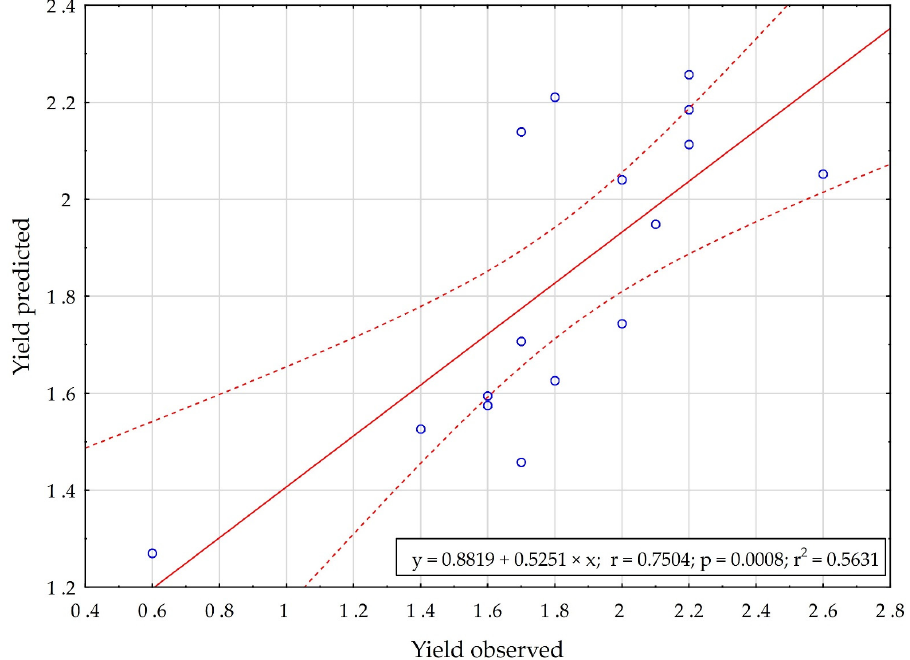
Figure 6. The scatter plot between the observed and predicted values of the soybean seed yield in model M_YIELD. model